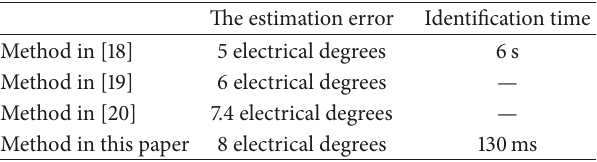
Table 2: The comparison between this method and other methods. The estimation